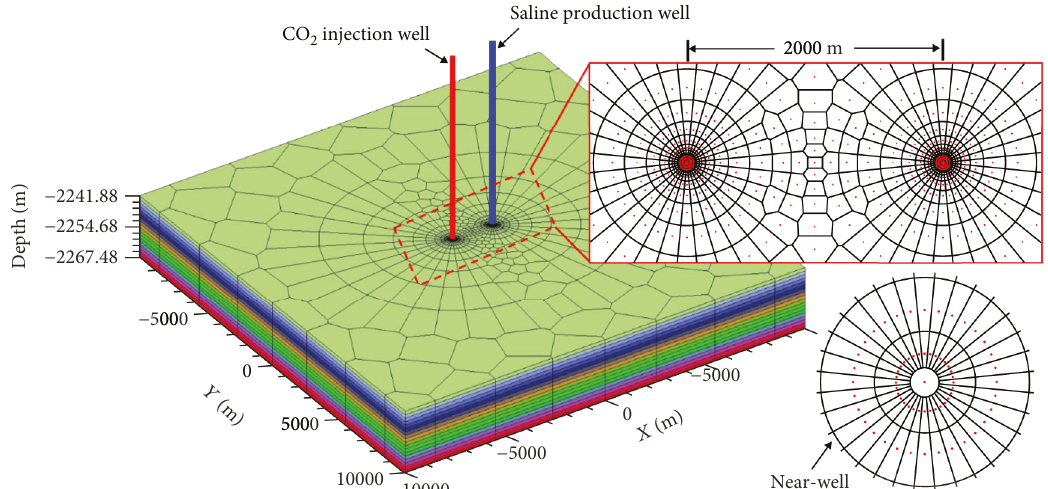
Figure 3: The 3D grid of the CO